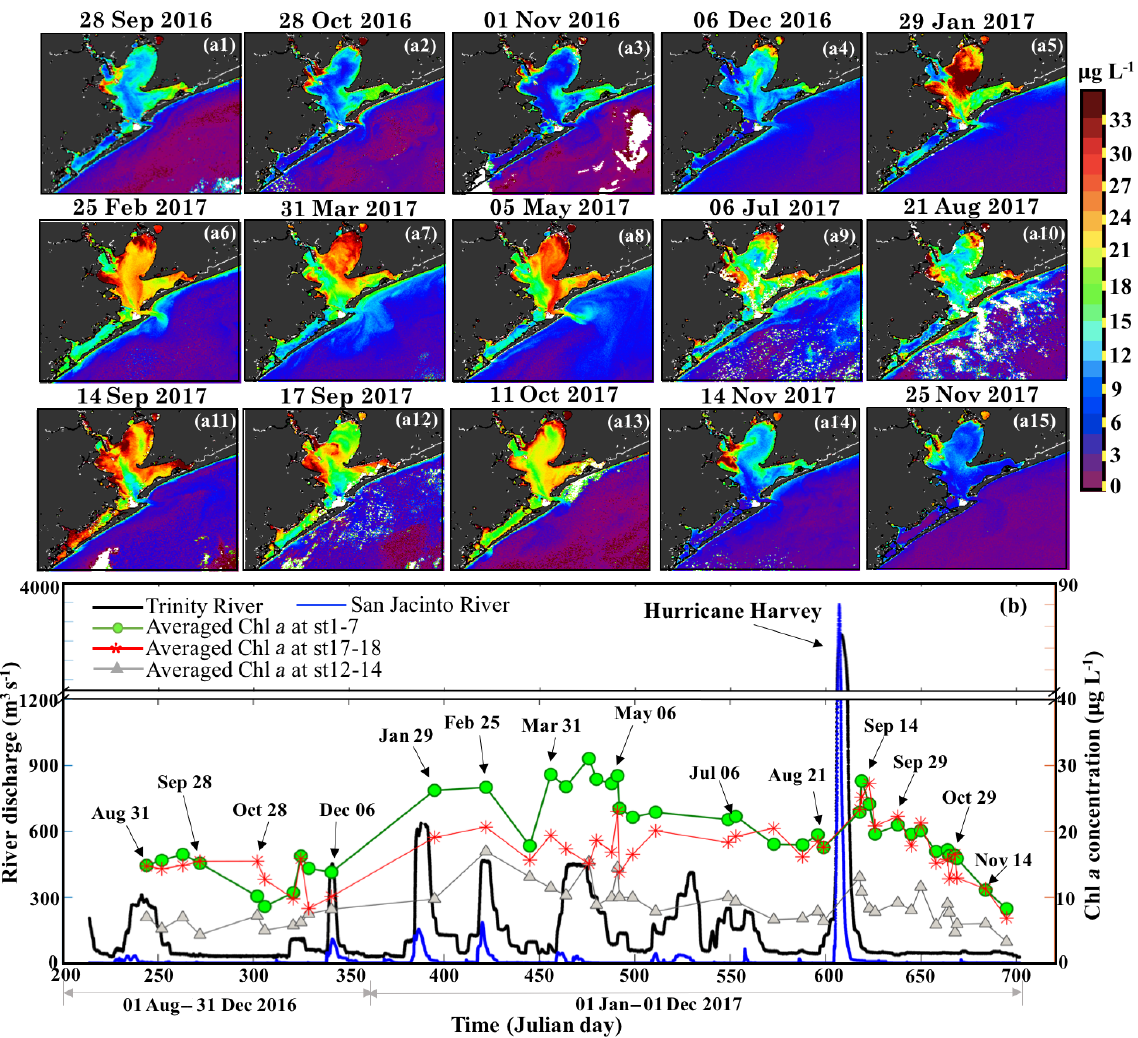
Figure 11. (a 1 − 15 ) OLCI-derived Chl a shown for the period of 31 August 2016–25 November 2017. (b) Trinity River discharge at Romayor, Texas (USGS 08066500; black line), and the west flank of the San Jacinto River (USGS 08067650; blue line); the green, red and gray lines and symbols represent the mean of Chl a at stations 1–7 in Trinity Bay, at stations 17–18 in East Bay and at stations 12–14 close to the entrance of GB corresponding to 43 cloud-free Sentinel-3A OLCI images (colored symbols; dated symbols correspond to images a 1 − 15